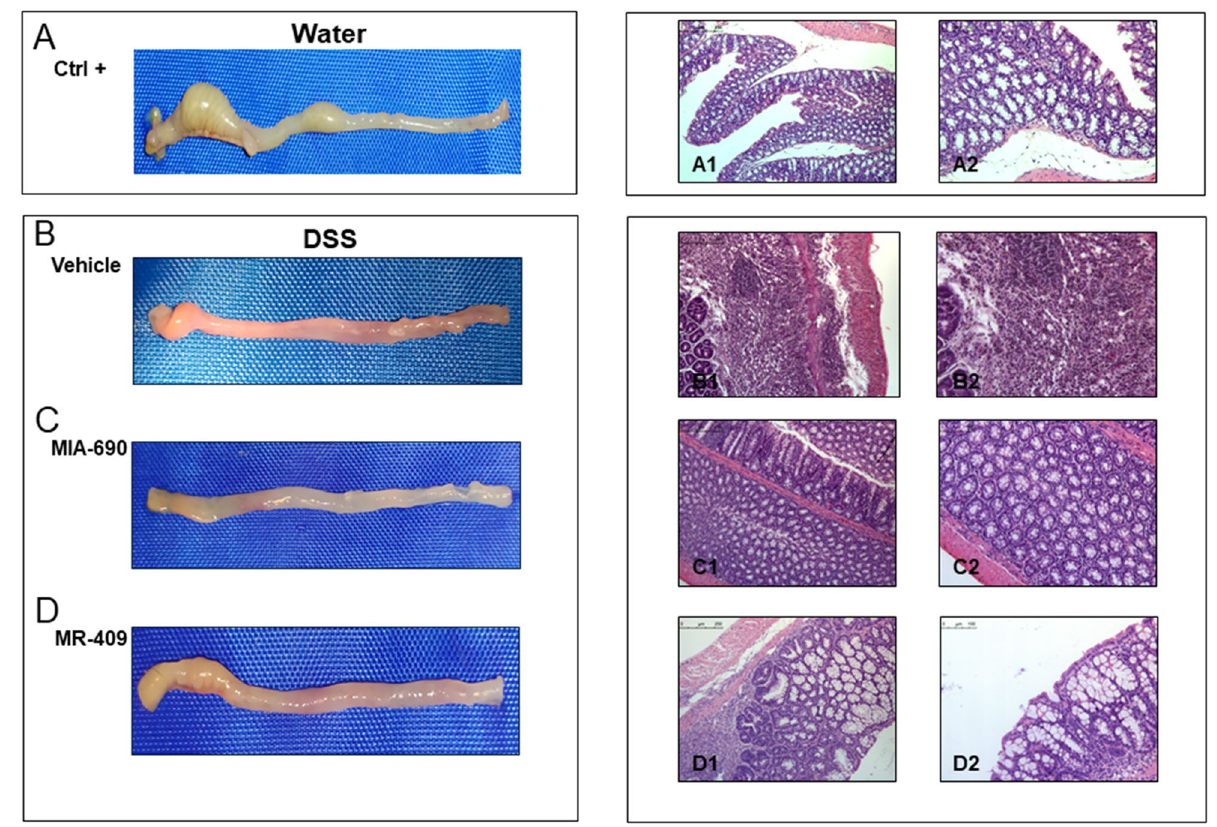
Figure 7. Effect of MIA-690 (5 µg) and MR-409 (5 µg) (n = 6 for each group of treatment) s.c. administration on macroscopic and histopathological changes of colon in a model of DSS-induced colitis. A (a1 and a2): normal colon segment; B (b1 and b2), C (c1 and c2) and D (d1 and d2): inflammation of colon segment in DSS-induced colitis; necrosis of epithelium, distortion of crypts, inflammation, infiltrates in lamina propria and submucosa as well as submucosal edema. Hematoxilyn and eosin stain: the inserted bars indicate magnification. [H&E staining, × 10 (a1, b1, c1, d1); × 20 (a2, b2, c2, d2) original magnification].